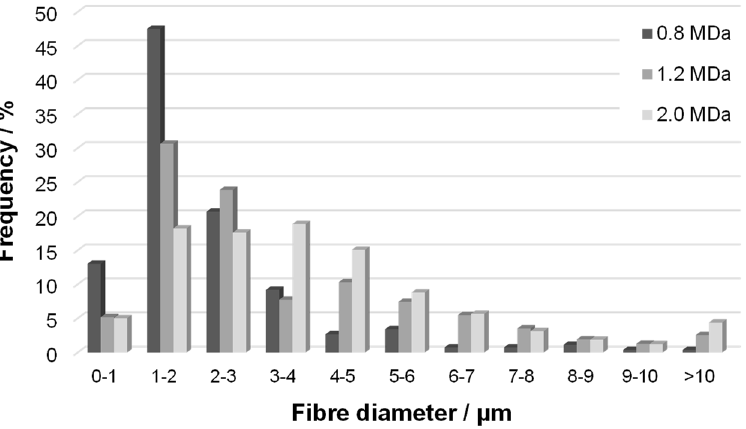
Figure 6. Distribution of fibre diameters (frequency) in nonwoven textiles prepared at Re 1950 from HA samples with various Mw.